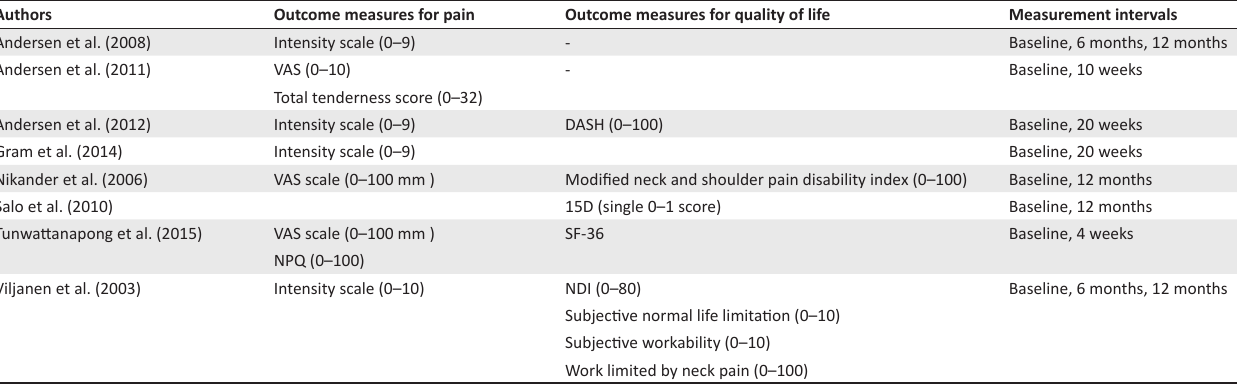
TABLE 4: Description of outcome measures.